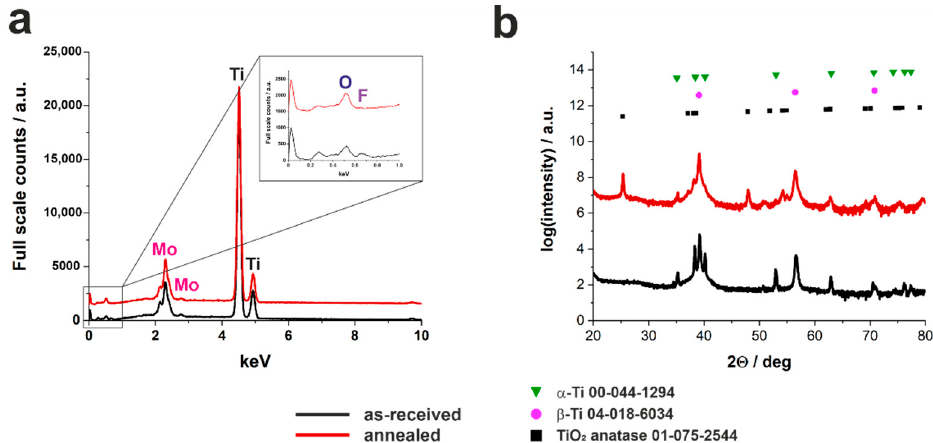
Figure 6. Exemplary EDS spectra ( a ) and XRD patterns ( b ) of the as-received (black lines) and annealed (red lines) Ti15Mo samples anodized at the constant potential (40 V in this case) for 15 min in the ethylene glycol-based electrolyte. The inset in ( a ) shows the magnification of the initial spectra region with the indication of oxygen and fluorine.